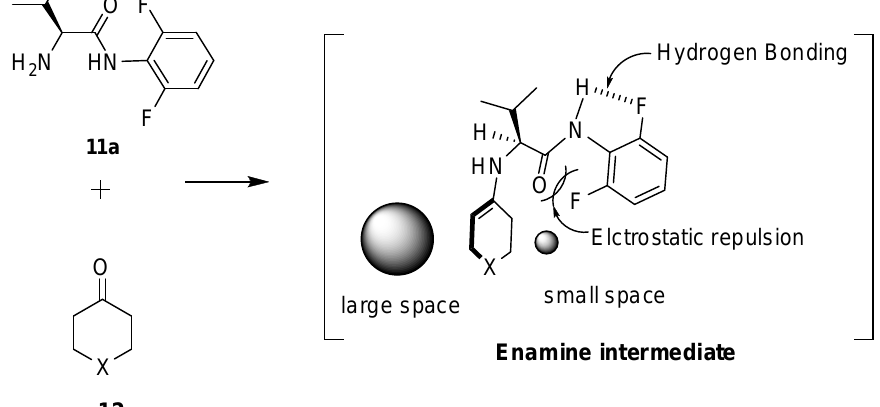
Figure 5. Concept of amino amide catalyst for asymmetric aldol reaction.